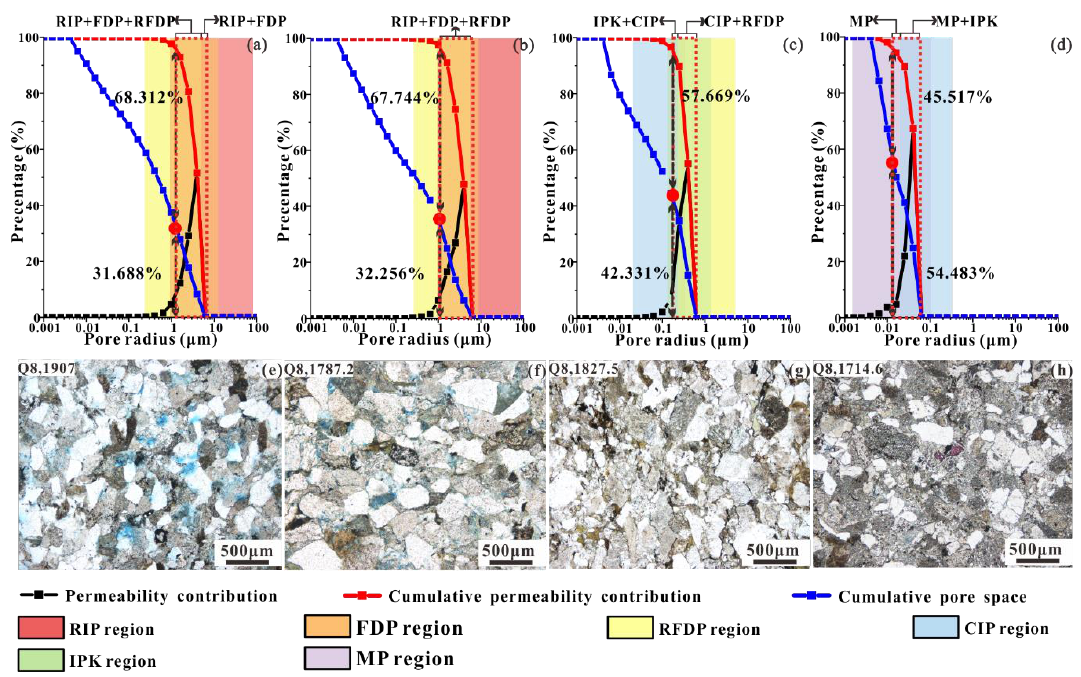
Figure 12. Permeability contributions of representative sandstone samples for four lithofacies.